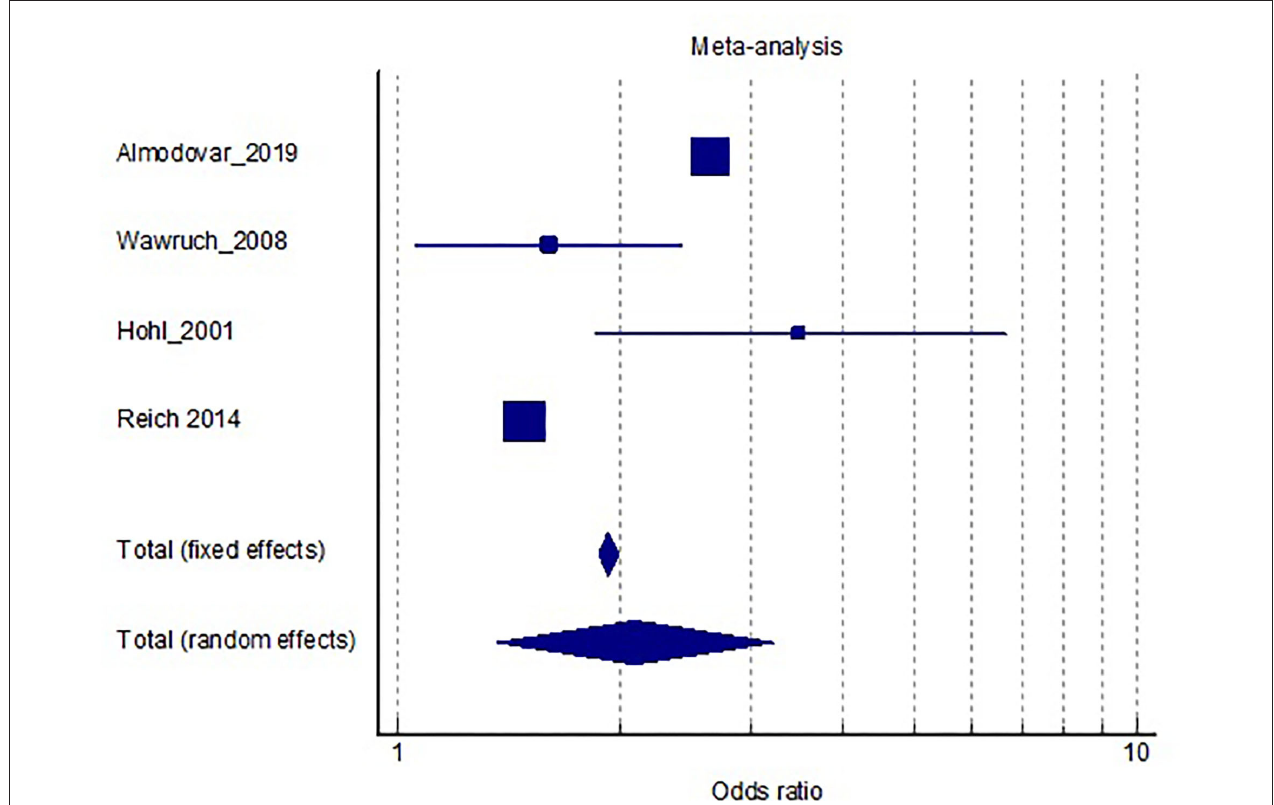
FIGURE 2 | Distribution of results and size of the effect regarding the risk of being prescribed a PIM with polypharmacy as a risk factor.